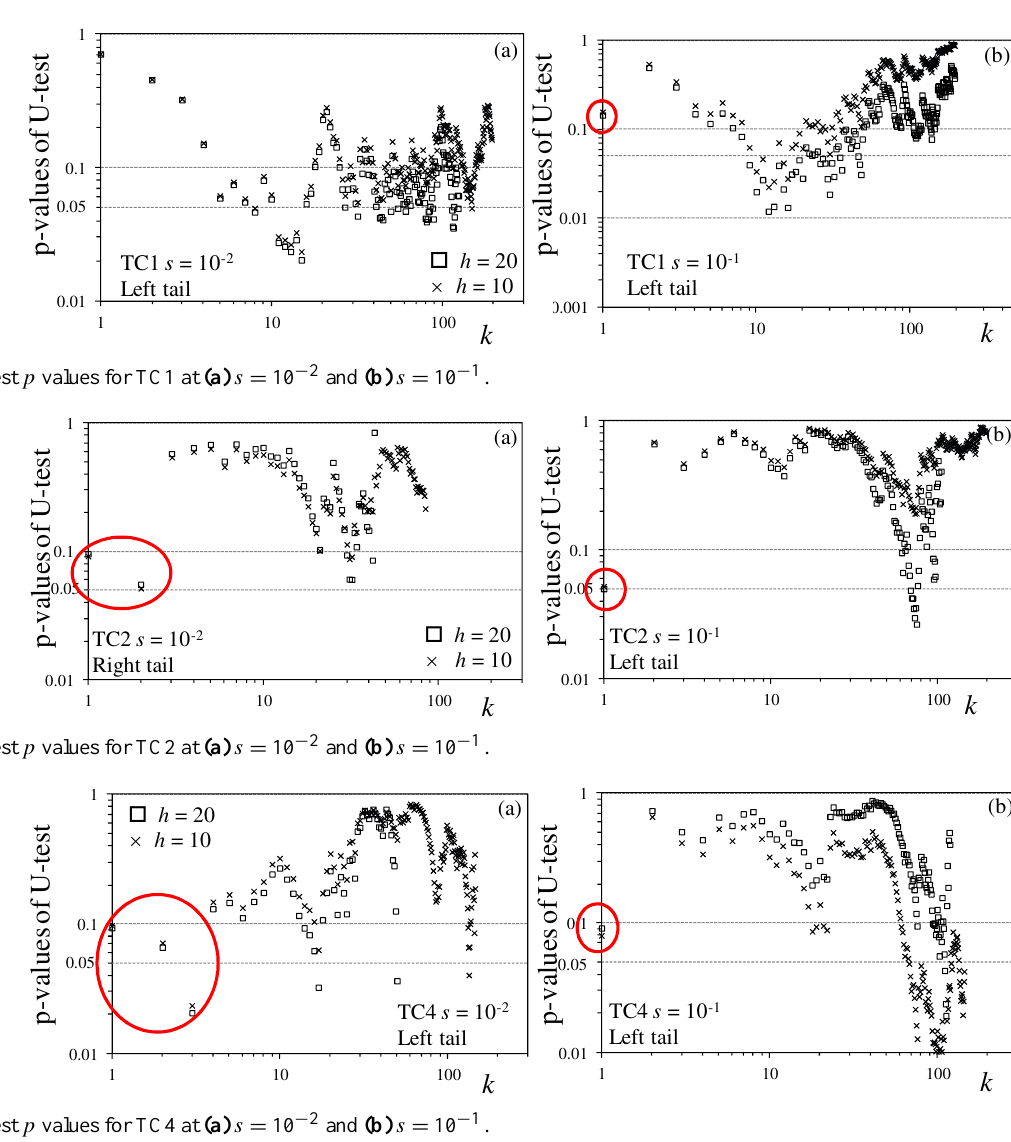
test on the right tail for various numbers n ∗ of events exceed- ing h . The plot clearly confirms the previous findings. In TC2 at s = 10 − 1 the highest ranked event on the left tail was iden- tified by both previous tests as a DK, in agreement with DK test results in Fig. 10b. In TC4 at s = 10 − 2 the three highest ranked events on the left tail were identified as DKs by both previous tests; setting r = 3 in the DK test yields a plot of p values versus n ∗ (Fig. 11a) that are generally larger than 0.1, in contrast to these previous tests. In TC4 at s = 10 − 1